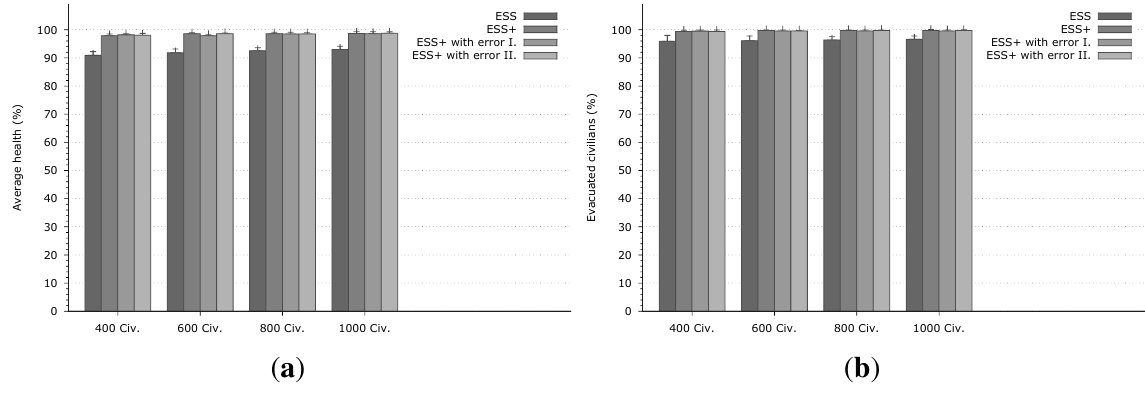
Figure 4. Results of the evacuation when the fire was generated at node 16 − 0 . In each group the first column Emergency Support System (ESS) indicates the same emergency system as proposed in [19]. The second one (ESS+) is the enhanced system but without any localization error (an ideal case). The third and fourth are the enhanced version as well but with localization noise (which follows the normal distribution with maximum of 2 and 10 m). ( a ) Average evacuee health vs. number of the civilians; ( b ) Evacuated civilians vs. number of the